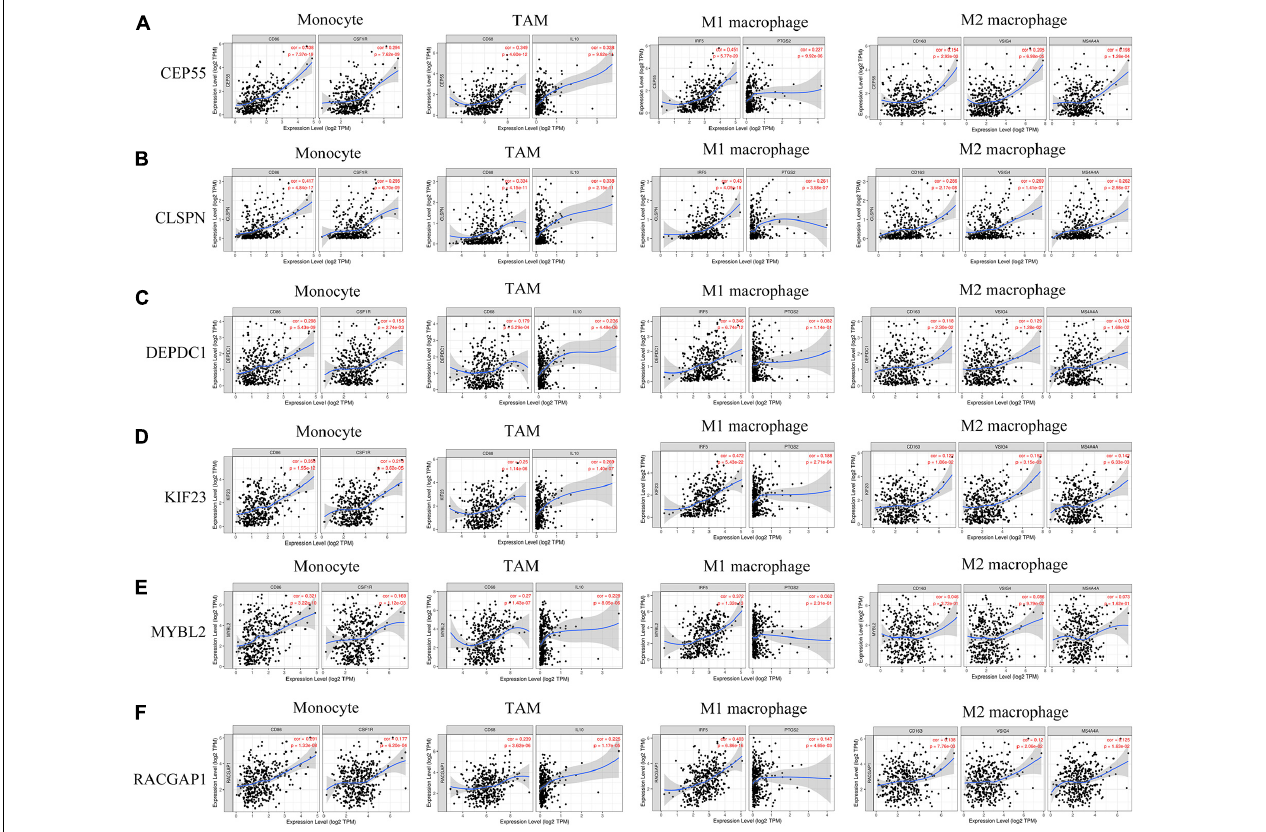
FIGURE 8 | (A–F) Six hub genes expression correlated with macrophage polarization in HCC. Markers include CD86 and CSF1R of monocytes; CD68 and IL10 of TAMs (tumor-associated macrophages); IRF5 and PTGS2 of M1 macrophages; and CD163, VSIG4, and MS4A4A of M2